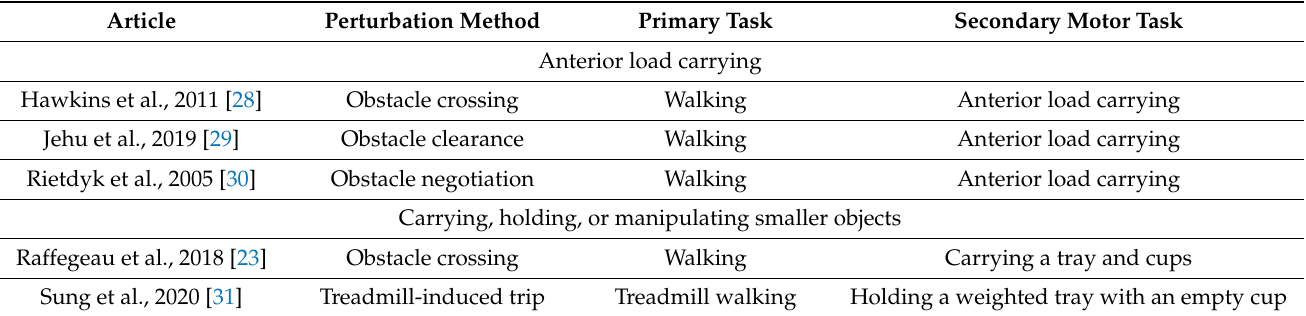
Table 2. Secondary motor tasks during trip recovery and obstacle